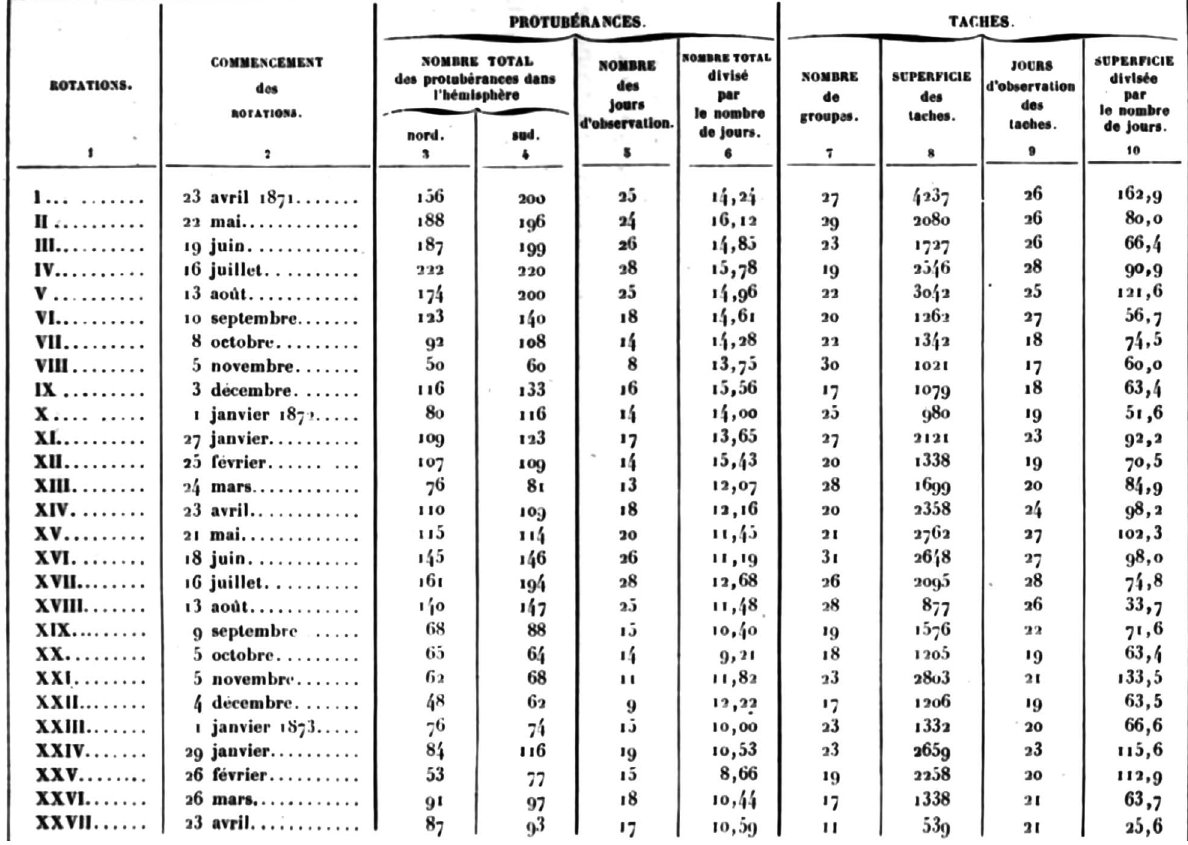
Fig. 1. Table A published by Secchi, including the sunspot and prominence observations during 1871 – 1875 [source: Secchi, 1875, p.